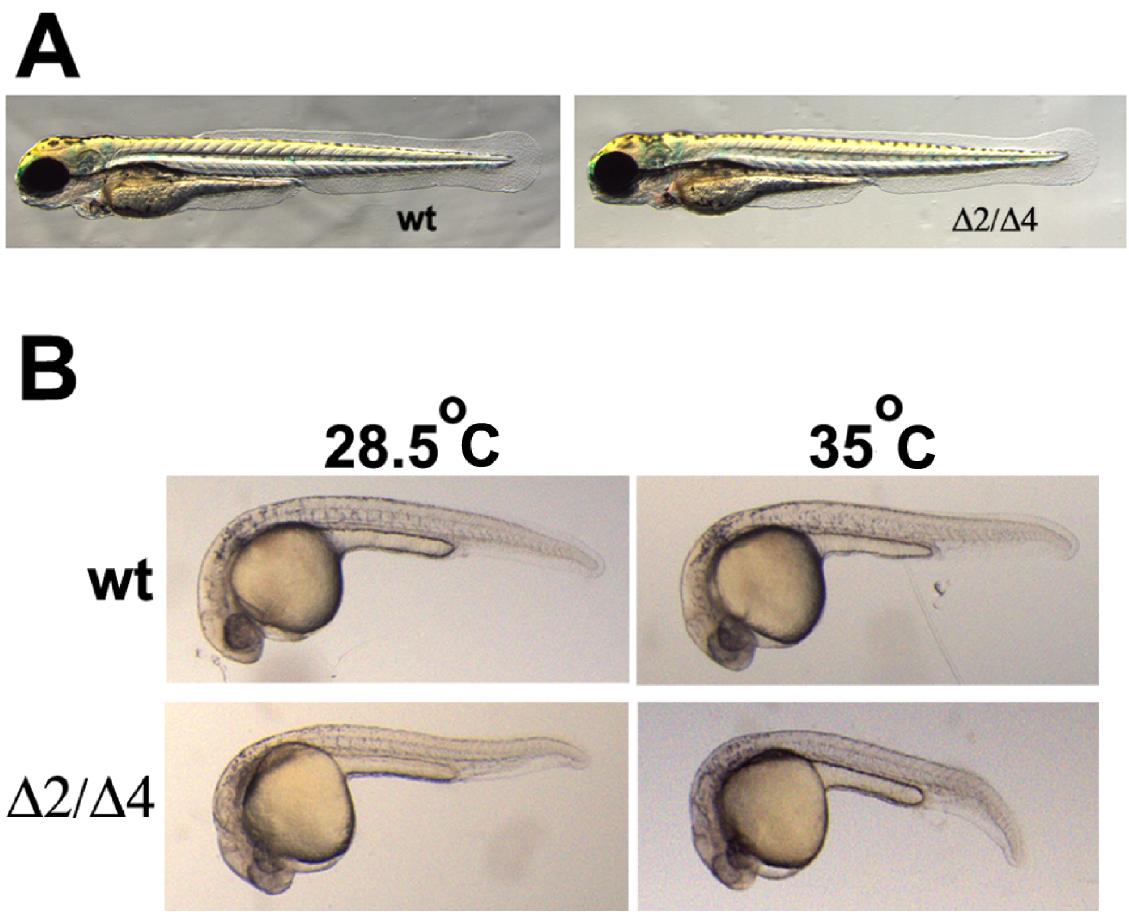
Figure 6. Testing for stress contribution to the pak4 MO phenotype. (A) Injection of standard control MO (6 ng) into wild type and pak4 mutant embryos. Live embryos at 3 dpf were anesthetized and photographed. Images shown are representatives of 92 out of 98 for wild type and 17 out of 17 for mutant. (B) Heat exposure of embryos. Wild type and F 3 mutants were exposed to 35 u C from blastula stage to 24 hpf. Control samples (28.5 u C) were incubated for 5 hours longer than the heated embryos in order to compensate for different developmental